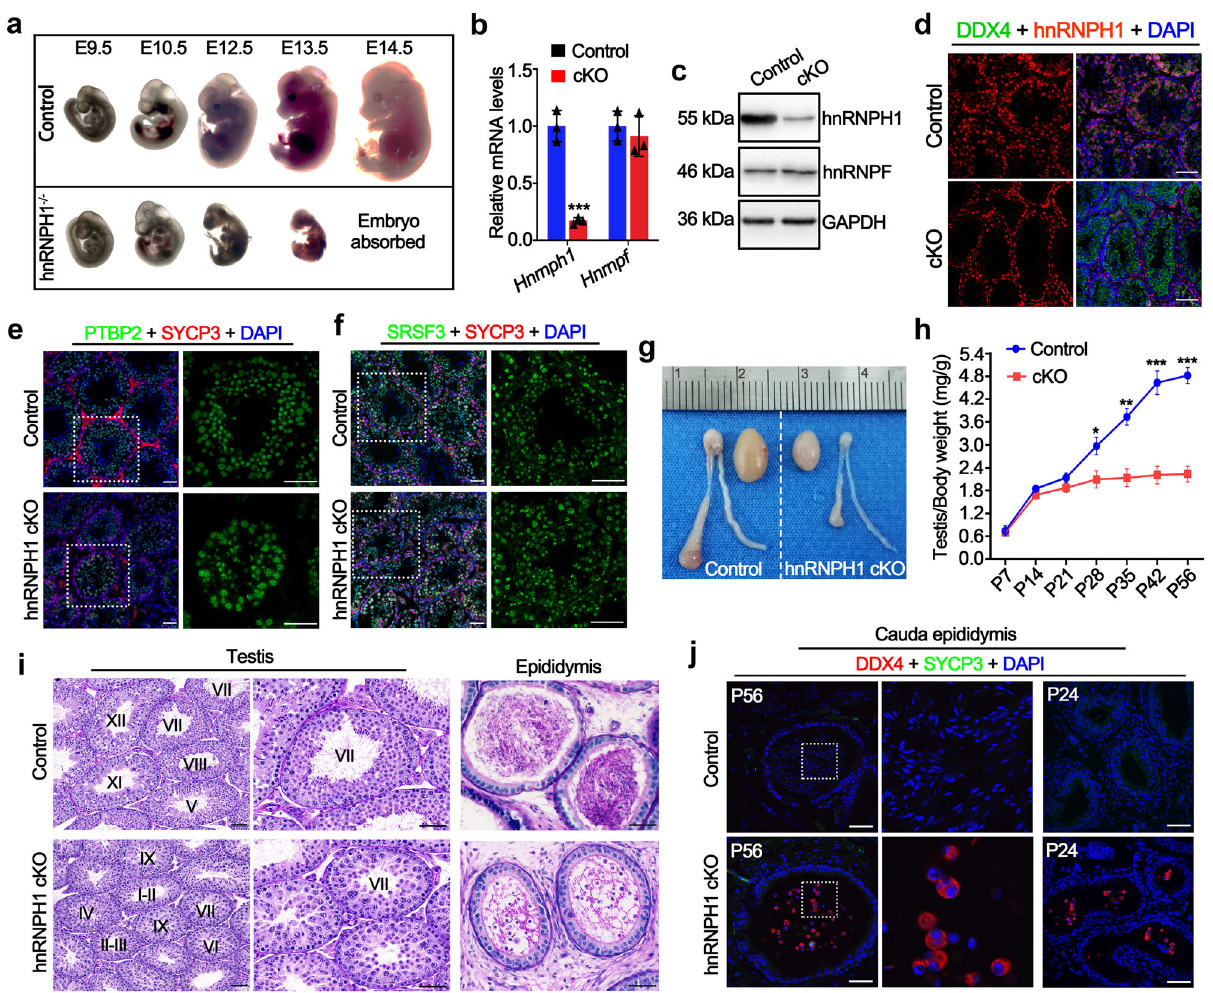
Fig. 3 hnRNPH1 is indispensable for embryonic development and male fertility in mice. a Representative embryos at various developmental time points, including embryonic day 9.5 (E9.5), E10.5, E12.5, E13.5, and E14.5, as derived from control and hnRNPH1 − / − mice. b Real-time qPCR analyses of Hnrnph1 and Hnrnpf mRNA levels in control and hnRNPH1 cKO testes of adult mice. Data were presented as mean ± SD, n = 3 (three biological replicates). A two- sided Student ’ s t -test was performed, *** p = 0.0005. c Western blotting analyses of hnRNPH1 and hnRNPF protein in control and hnRNPH1 cKO testes of adult mice. GAPDH was used as a loading control. d Immuno fl uorescence (IF) staining of hnRNPH1 in control and hnRNPH1 cKO testes of adult mice. DDX4 was co-stained to indicate the location of the germ cell. The DNA was stained with DAPI. Scale bars = 50 μ m. e – f Co-immuno fl uorescence staining of PTBP2 ( e ) and SRSF3 ( f ) with SYCP3 in testis sections from adult control and hnRNPH1 cKO mice. The DNA was stained with DAPI. Scale bars = 50 µ m. g Gross morphology of the testes and the epididymides from adult control and hnRNPH1 cKO mice. h Testis growth curves of control and hnRNPH1 cKO mice from postnatal day 7 (P7) to P56. Data were presented as mean ± SD, n = 3 (three biological replicates). A two-sided Student ’ s t -test was performed, left to right: ** p = 0.0089, *** p = 0.0009, *** p = 0.0004, *** p = 0.0001. i Periodic acid-Schiff (PAS) staining of testes and epididymides from control and hnRNPH1 cKO mice at P56. Scale bars = 50 μ m. j Co-immuno fl uorescent staining of DDX4 with SYCP3 on control and hnRNPH1 cKO cauda epididymidis sections at P56 and P24, respectively. Scale bars = 50 μ m. Biologically independent mice ( n = 3) were examined in three separate experiments ( c – f , i , j ). Source data are provided as a source data fi (Supplementary Data 6). Of note, in PTBP2 null testes, SE also accounted for the most signi fi cant proportion (83.2%) among 5 alternative splicing types (Supplementary Fig. S6e). Further analysis revealed that hnRNPH1 and PTBP2 share many alternative splicing genes (Fig. 4d) and events (Fig. 4e) in